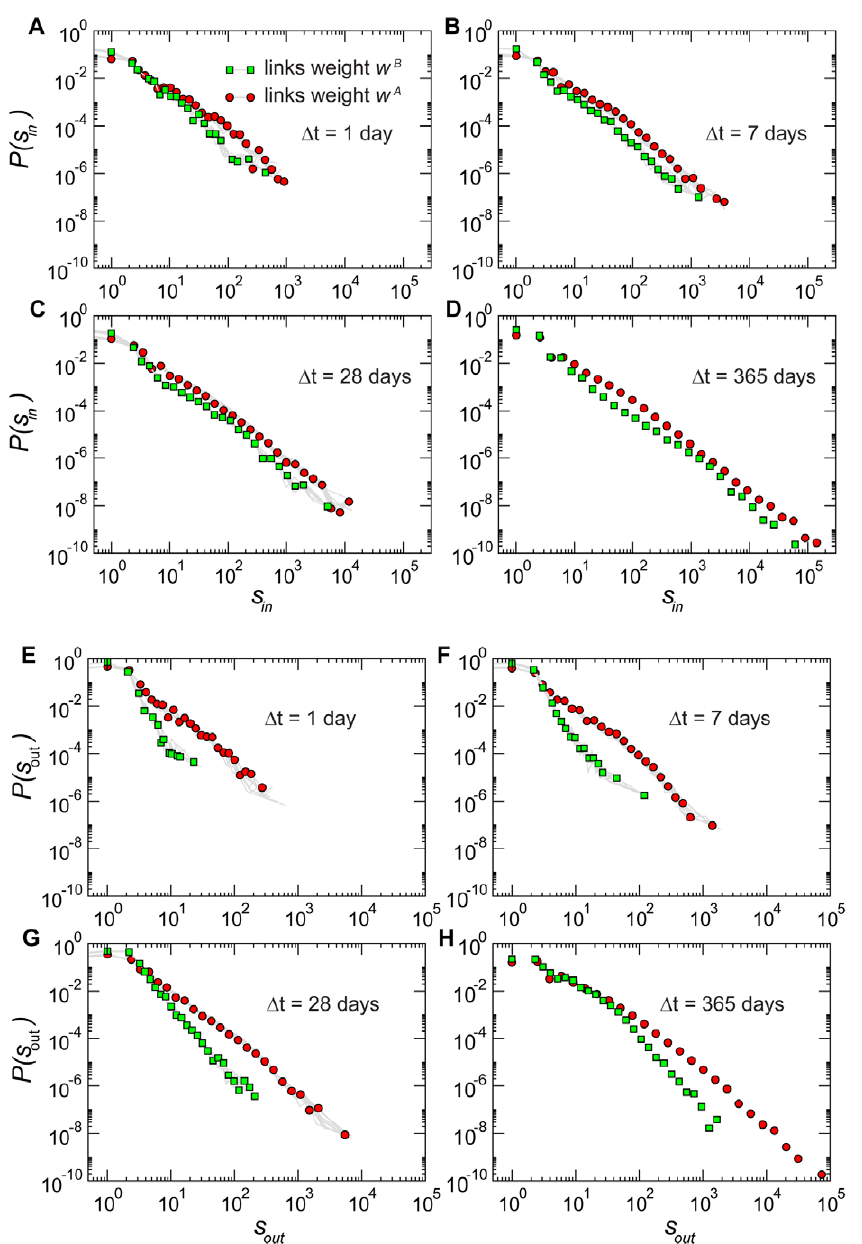
Figure 2. Strength distributions for networks aggregated on different timescales D t . Panels A to D report the distributions of the in- strength s in . Interestingly, the definition used to weight the links does not affect the distribution of the incoming traffic: the distributions P ( s A P ( s B ) are very close. Panels E to H present the distributions of the out-strength s out , whose behavior instead depends strongly on the type of weight in considered. Broader tails are observed when considering the total number of animals displaced out of a given holding. The same representation of Figure 1 is adopted, with symbols representing the result of a particular snapshot, and grey lines the results obtained for a subset of the other snapshots.